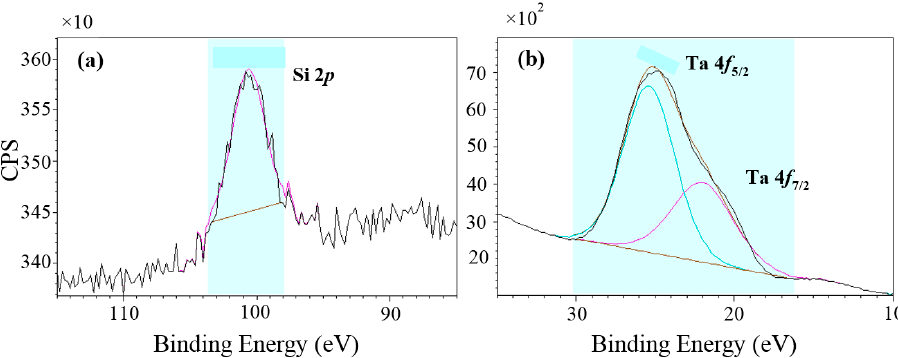
Figure 4. High-resolution deconvoluted spectra of ( a ) Si 2 p and ( b ) Ta 4 f core levels. (CPS: counts per second.).